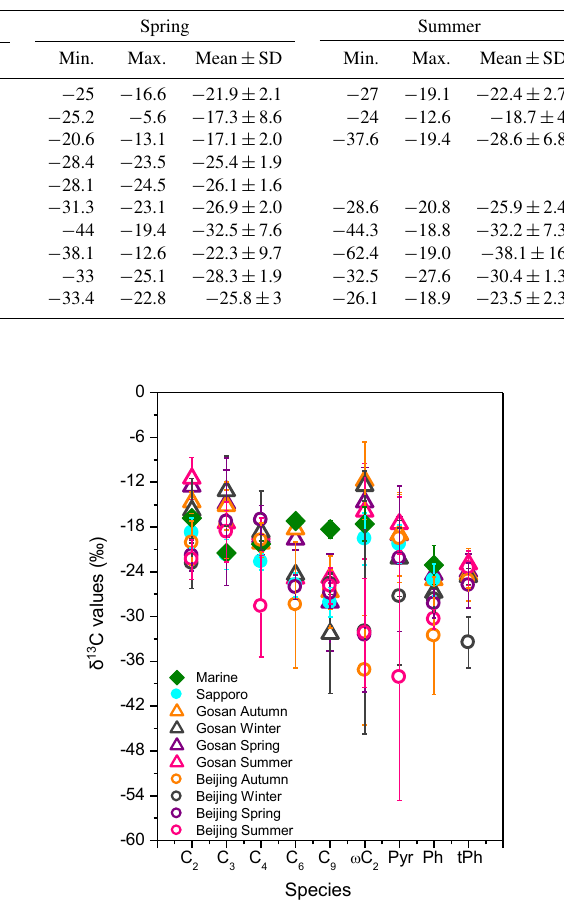
Figure 7. Seasonal mean δ 13 C values of selected diacids and re- lated compounds detected in PM 2 . 5 in Beijing. Data from Sapporo (Aggarwal and Kawamura, 2008); Gosan, Jeju Island (Zhang et al., 2016); and marine (Kawamura and Watanabe, 2004; Wang and Kawamura, 2006) aerosols are also plotted. The bar represents the standard variation ( ± SD) in the δ 13 C